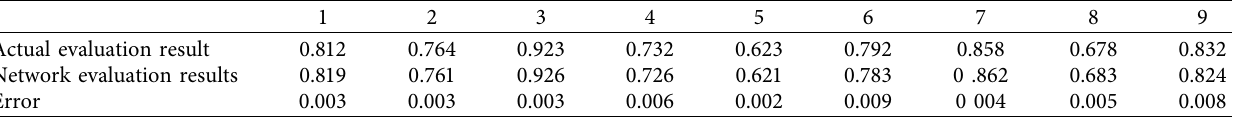
Table 7: Comparison of actual evaluation results and simulation evaluation